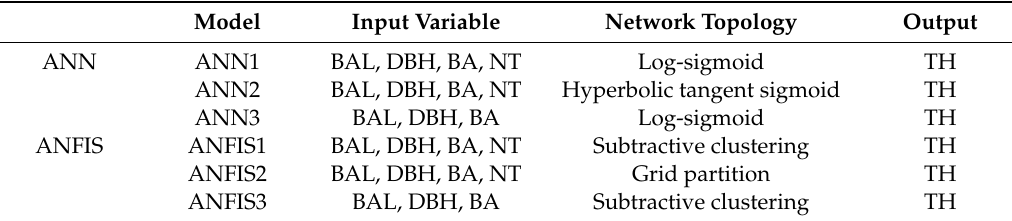
Table 2. Descriptions of ANN and ANFIS with their activation functions and input and output variables for estimating total